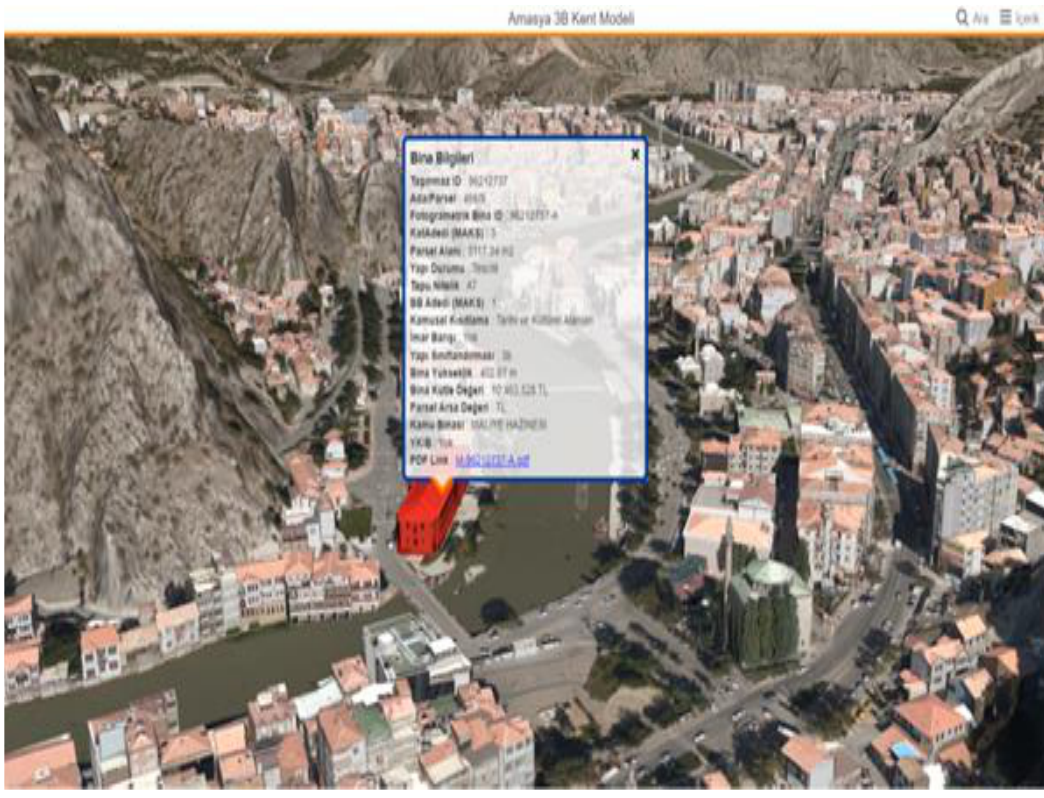
Figure 7. Open Source